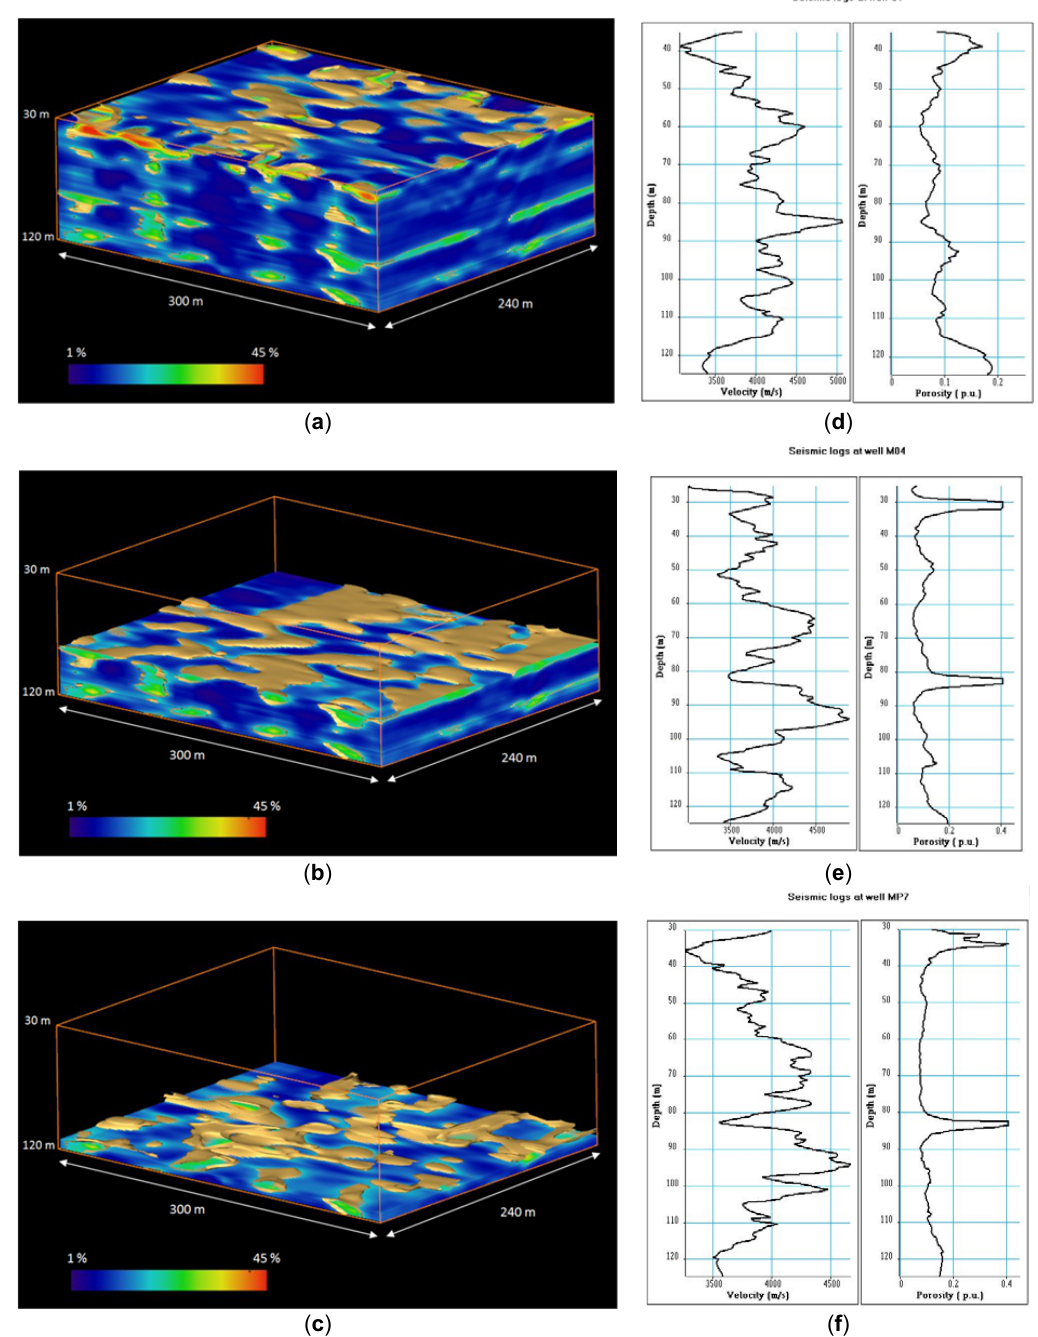
Figure 5. Distribution of karstic bodies from the 3D seismic block ( a ) at depth of 35–120, ( b ) 85–120, ( c ) 115–120 m. Seismic velocity and porosity vertical distribution at wells ( d ) C1, ( e ) M04, ( f ) MP7.